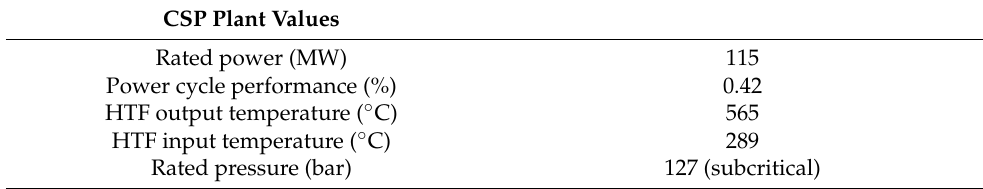
Table 2. CSP plant parameters used in the